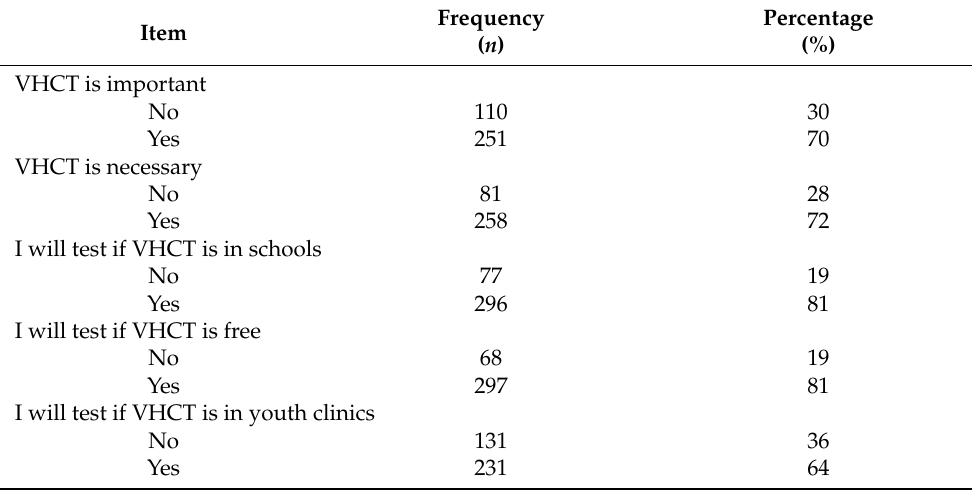
Table 3. Young people’s attitudes toward VHCT